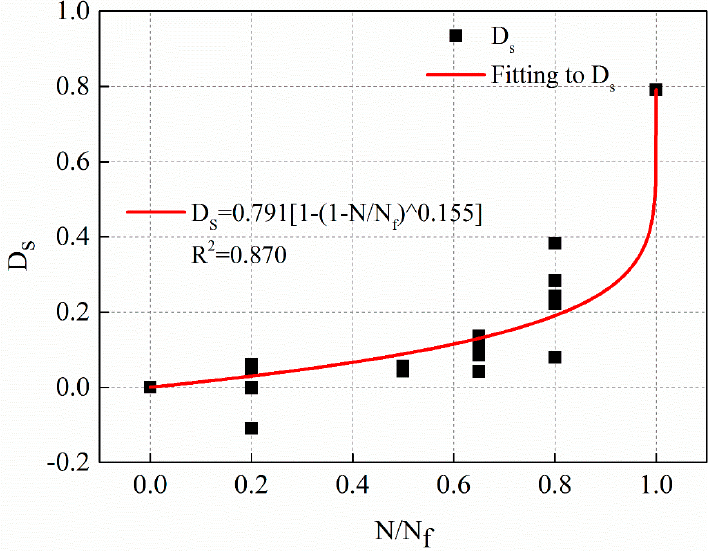
Figure 18. The fatigue damage evolution curve based on residual strength decay with stress levels of 1 MPa.